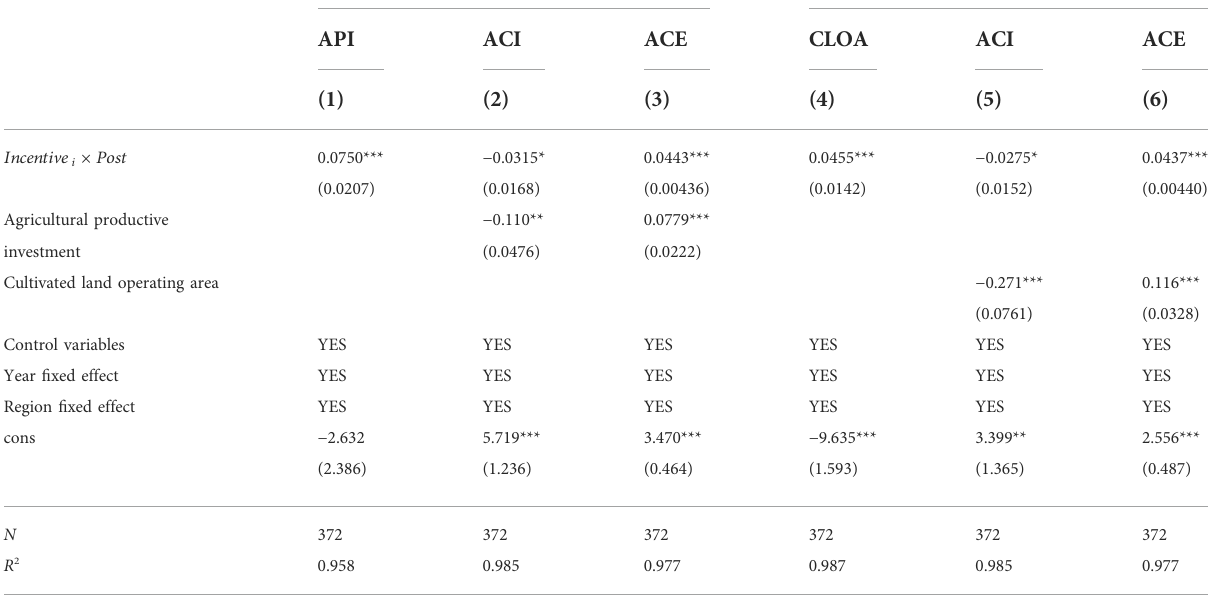
TABLE 6 Mechanism identi fi cation: farmer ’ s